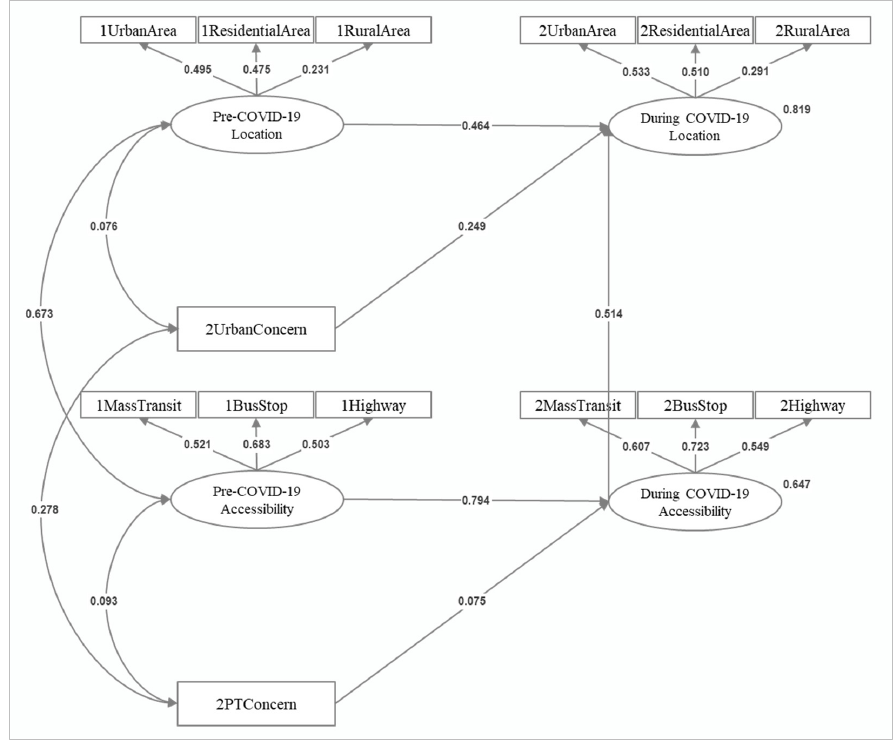
Figure 6. Pre-test and post-test model specification and standardized estimates. Table 11. Parameter estimates of regression weight and correlation of model result. Regression